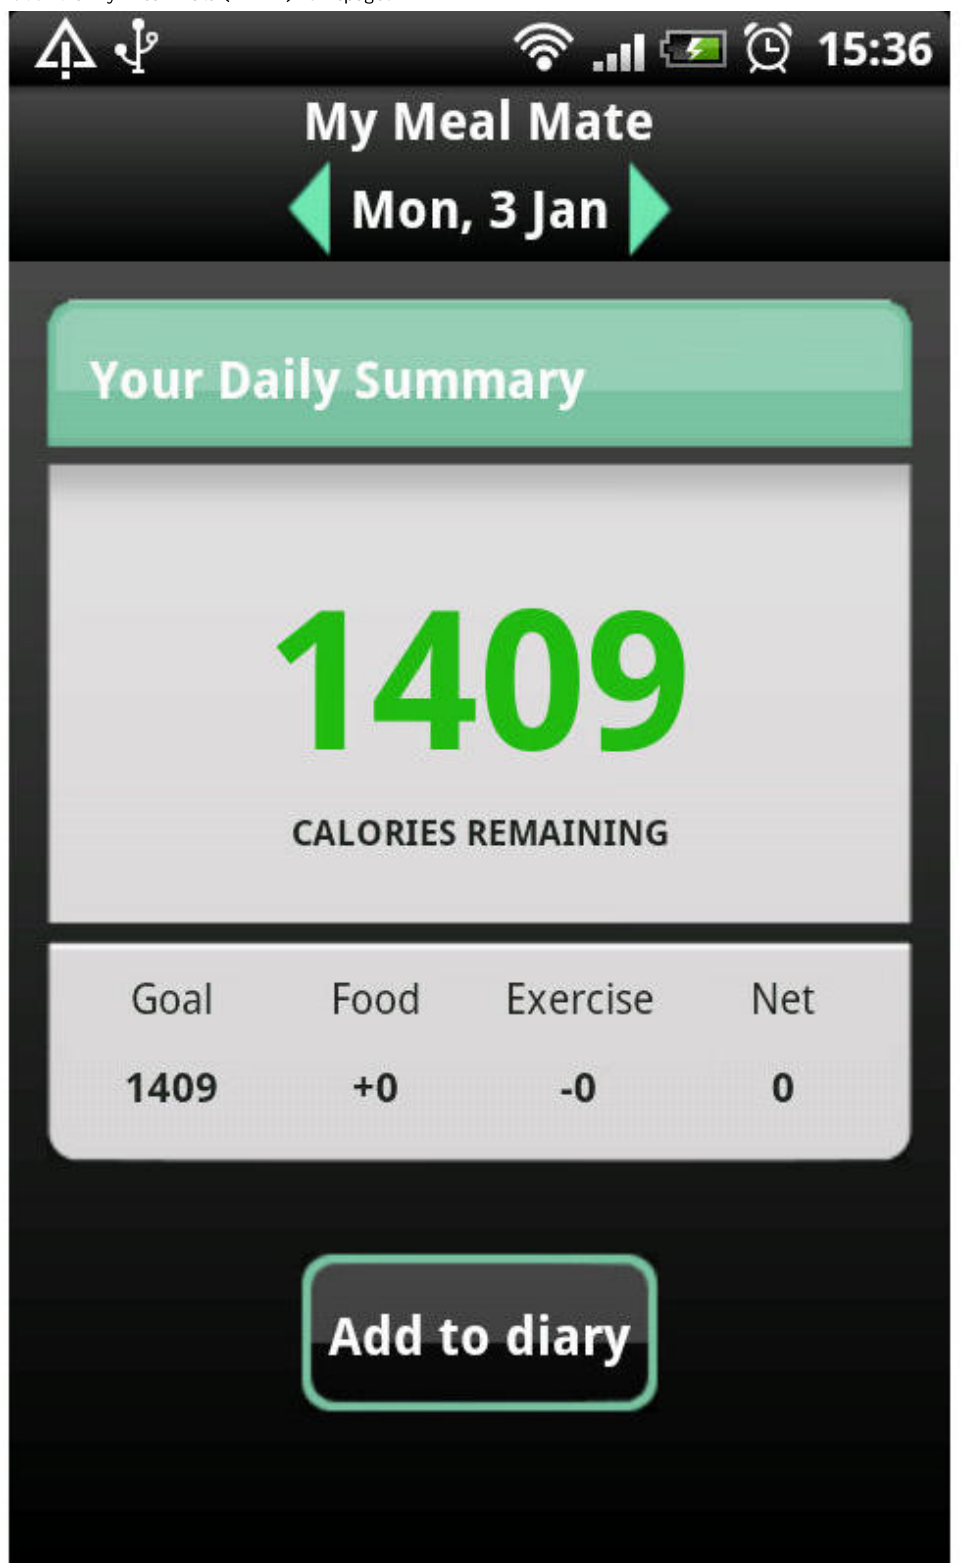
Figure 1. Screenshot of the My Meal Mate (MMM)